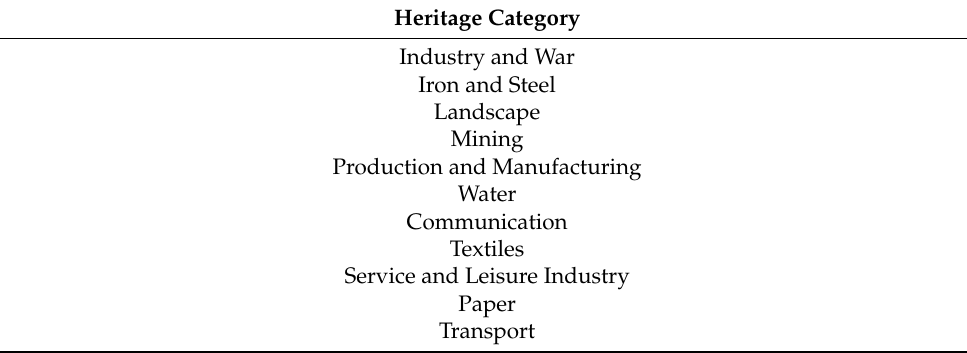
Table 3. Main categories of the Belgian industrial